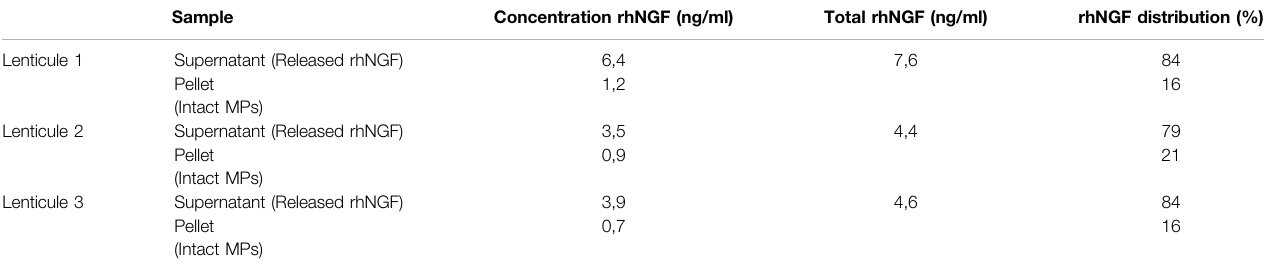
TABLE 2 | Title evaluation of rhNGF obtained from funtionalized lenticules.